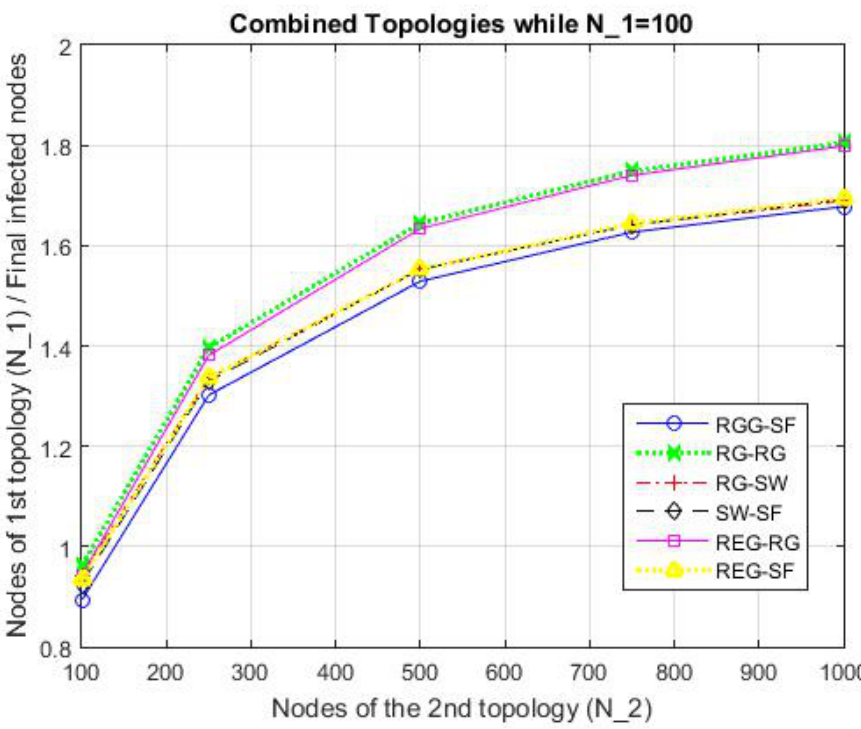
Figure 8. Spread of malware while the nodes of the 1st topology remain equal to N_1 = 100.